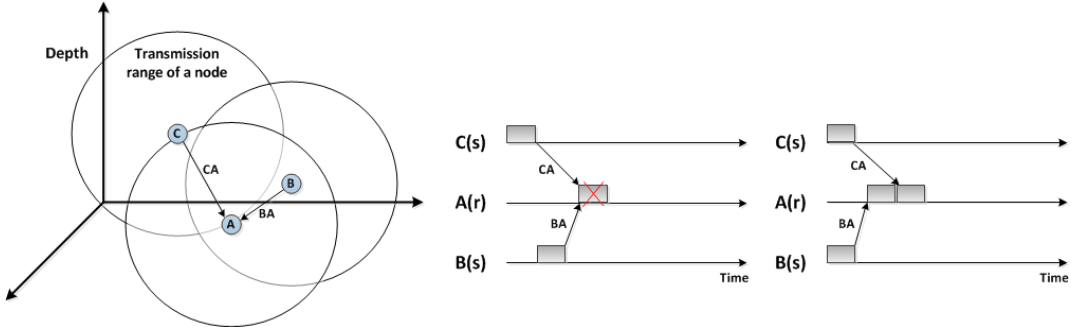
Figure 2. Impact of the hidden terminal problem and the long propagation delay on underwater MAC